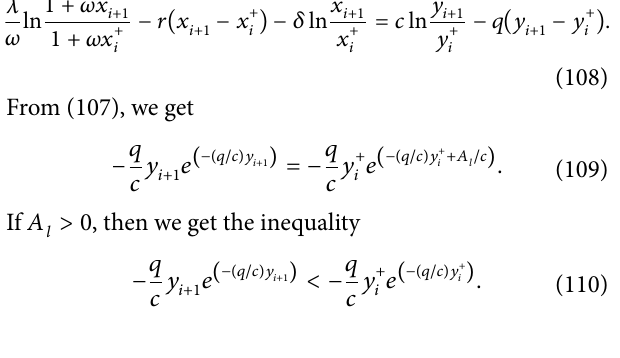
Figure 5: Fixed point of Poincaré map for Case 훿 = 0.3